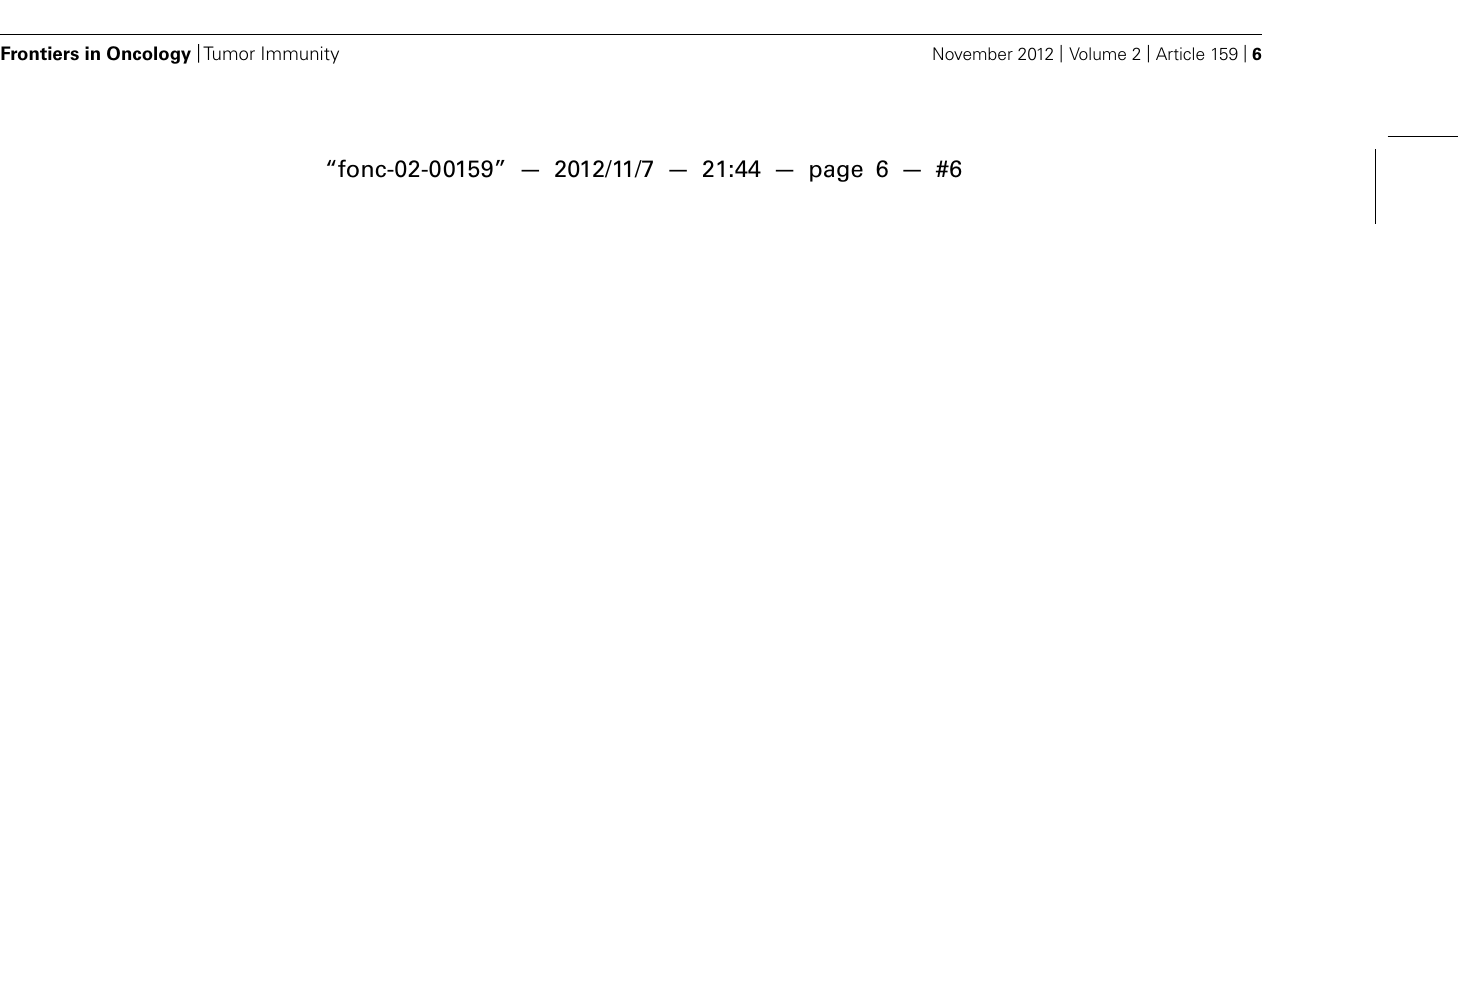
internalizing receptors, or by APC-specific ligands. Antigen is efficiently internalized, processed and presented to activate CD4 + and/or CD8 + T cells.